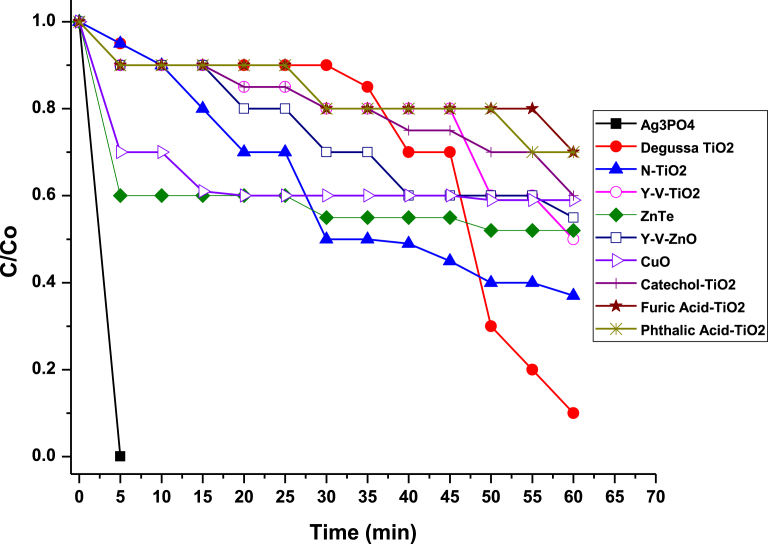
Comparison of the efficiency of Ag3PO4 photocatalysts with other common photocatalysts.